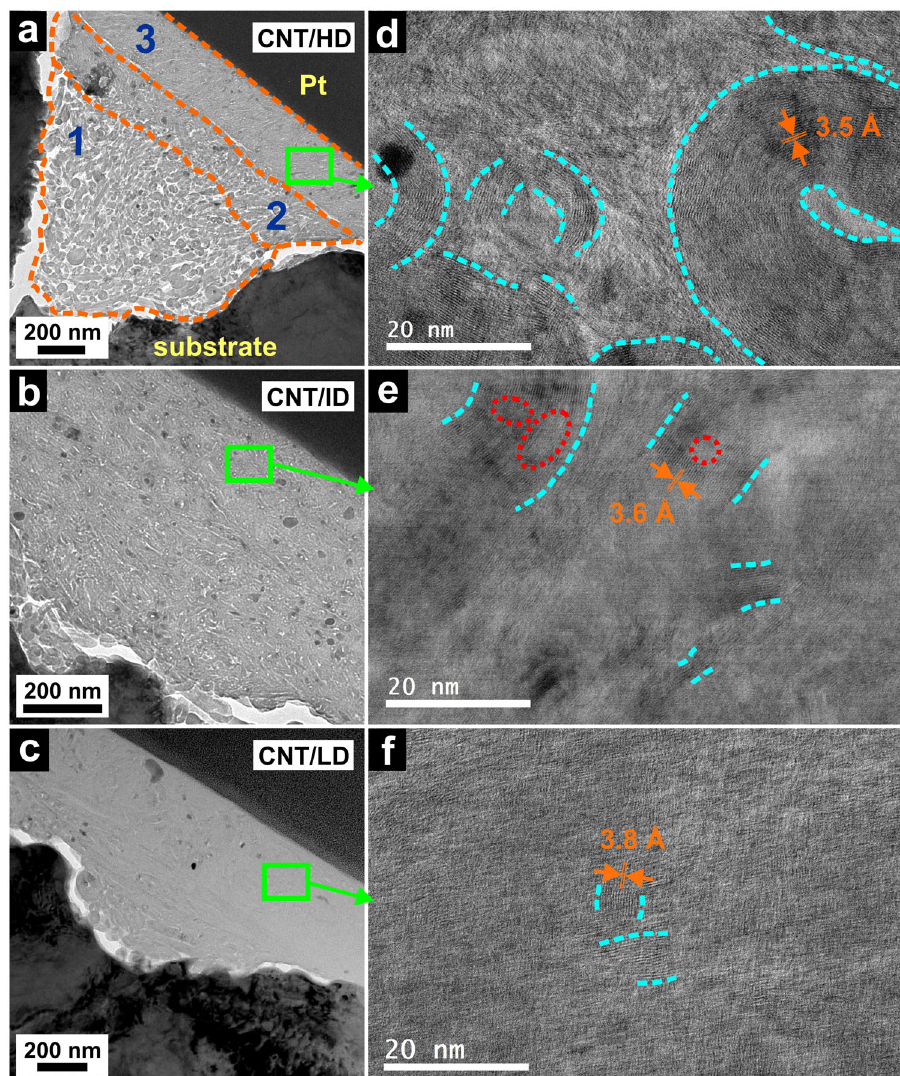
Fig. 6 Post friction test, cross-sectional TEM images of the CNT coatings. Representative images of the tribo fi lm at lower magni fi cation on a HD, b ID, and c LD. Representative images of the tribo fi lm close to the interface at higher magni fi cation on d HD, e ID, and f LD. Identi fi able CNT fragments are contoured in teal. The red circles in ( e ) represent noncrystalline areas within the CNT